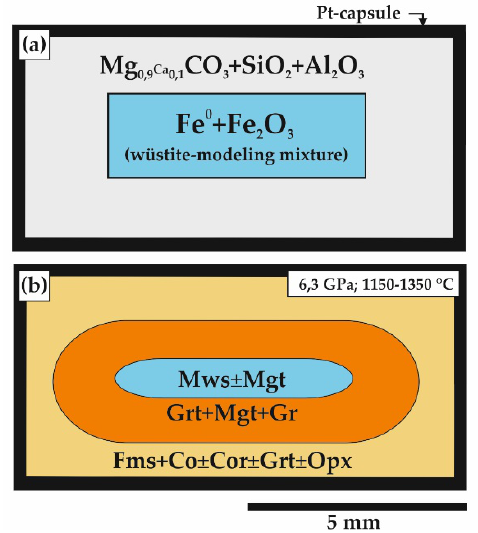
Figure 10. A scheme of an initial ampoule assembly ( a ) and scheme of ampoule after experiments on carbonate-oxide interaction ( b ); Mws: magnesiowüstite, Mgt: magnetite, Grt: garnet, Opx: orthopyroxene, Gr: graphite, Fms: ferromagnesite, Co: coesite, Cor: corundum.